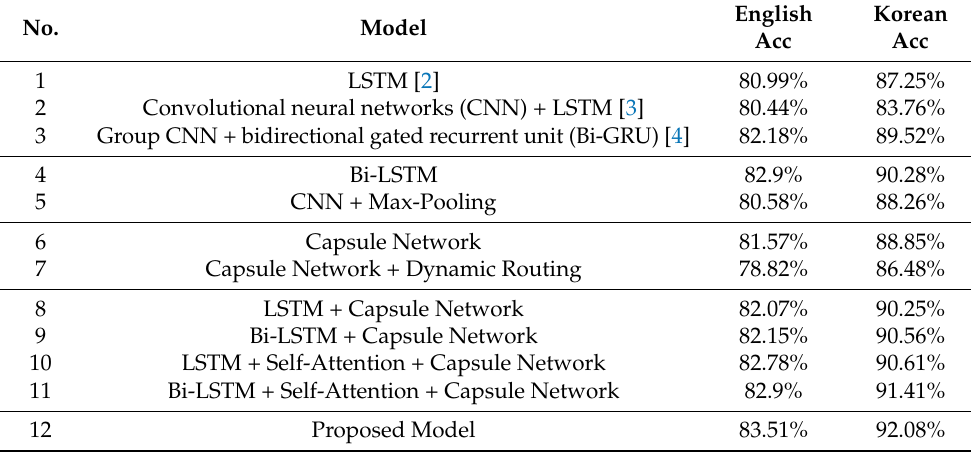
Table 4. Model accuracy comparison according to experiments.